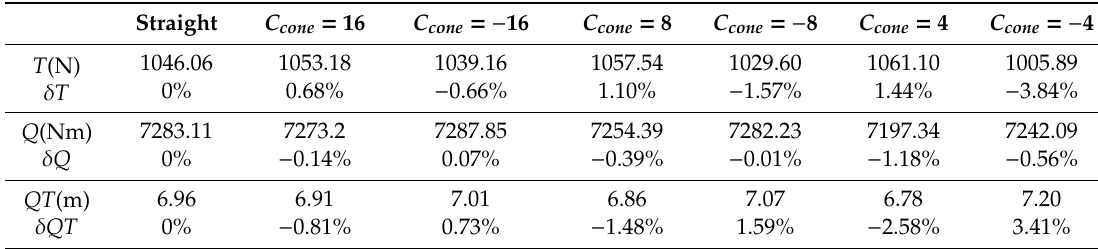
speed 9 m / speed 9 m/s.